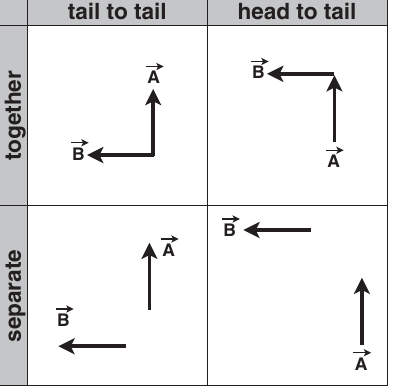
FIG. 3. The same orientation, ðþ ˆ y Þ × ð − ˆ x Þ ¼ þ ˆ z , with the vectors Head to tail , Tail to tail , Together , and Separate .